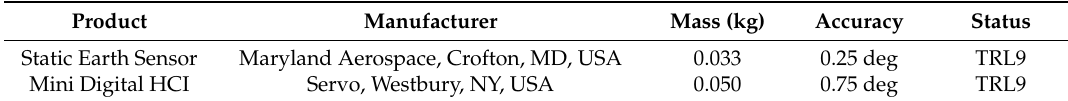
Table 20. Earth Sensor Performance Data [23].